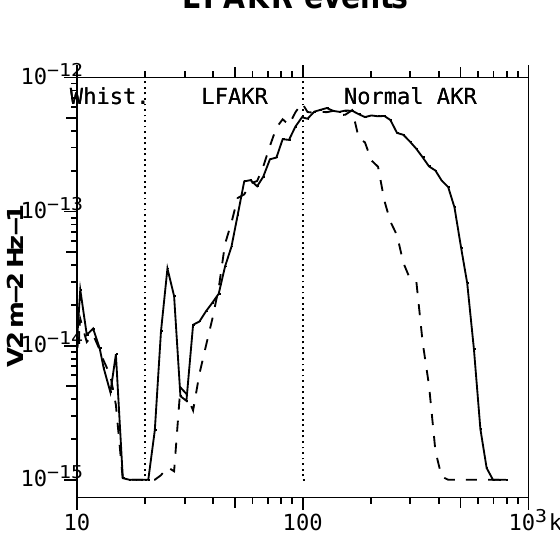
Fig. 1. Arithmetically averaged power density of AKR for low- frequency AKR events (LFAKR) plotted as a function of frequency, obtained from Polar PWI measurements. Solid line corresponds to winter months (November-February) and dashed line to sum- mer months (May-August). Most of the plot corresponds to normal AKR, while LFAKR contribution is seen in the frequency range 30–50kHz. Power in the range 10–15kHz is not AKR but due to whistler wave activity since its frequency is below the local elec- tron gyrofrequency. The peak at 25kHz is due to a single strong dot-AKR event at this frequency (18 November 1996, 14:37